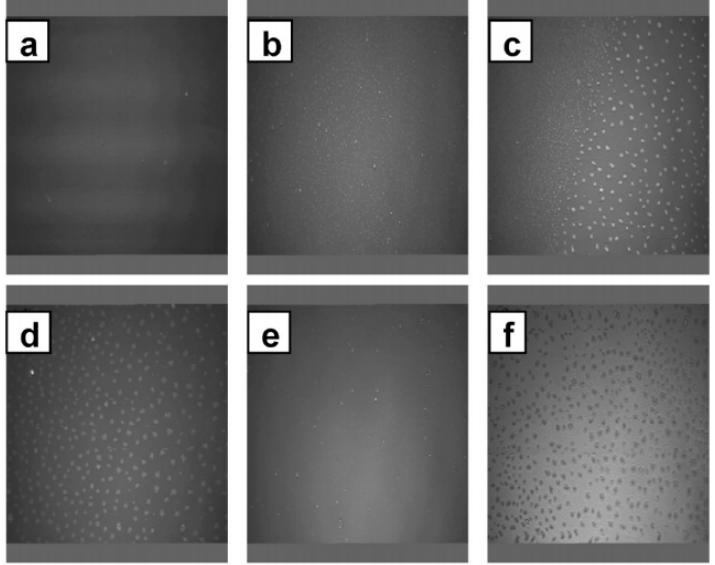
Figure 8. BAM micrographs (image sizes: 480 μm × 599 μm) of 33 mol% TBdSC (trimethyl-β-CD-disuccinyl-cholesterol) in DPPC Langmuir monolayers at the air/water interface at 20 °C and from upper left at ( a ) 0; ( b ) 14; ( c ) 22; ( d ) 34; ( e ) 40; and ( f ) 44 mN/m [16]. Reprinted with permission from [16]. Copyright 2011, American Chemical